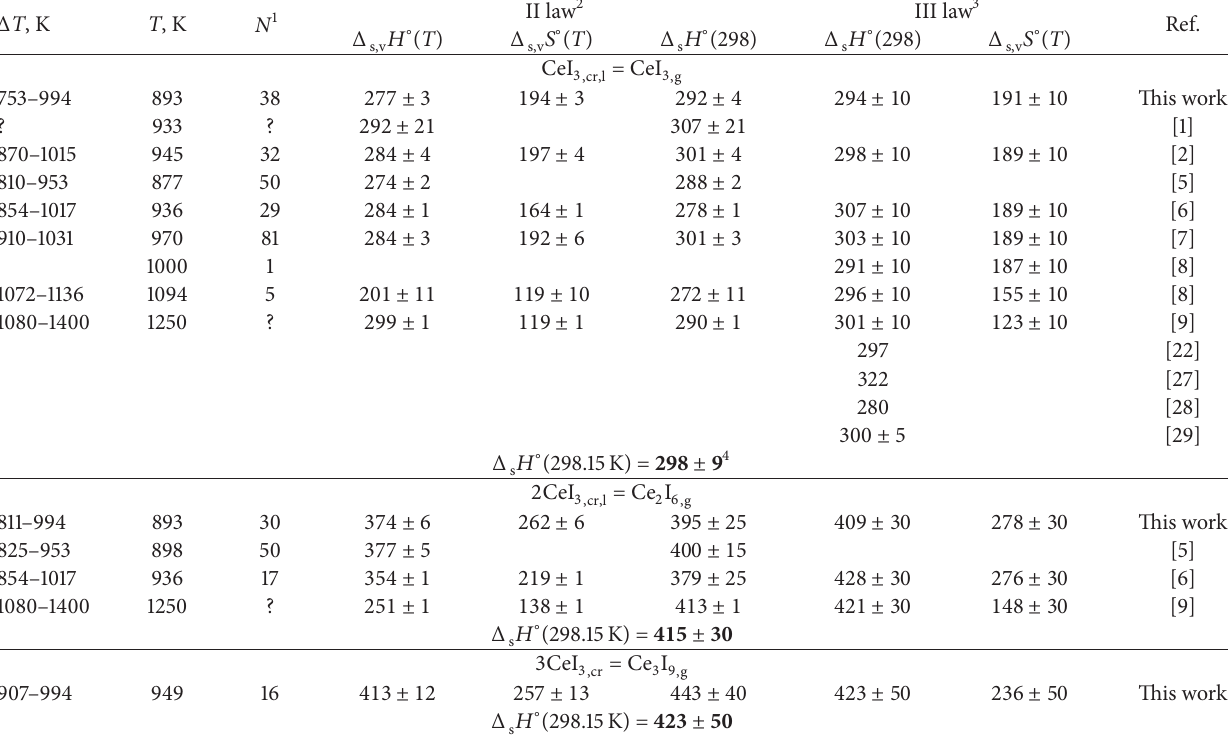
𝐻 ∘ (kJ ⋅ mol −1 ), and entropies, Δ s